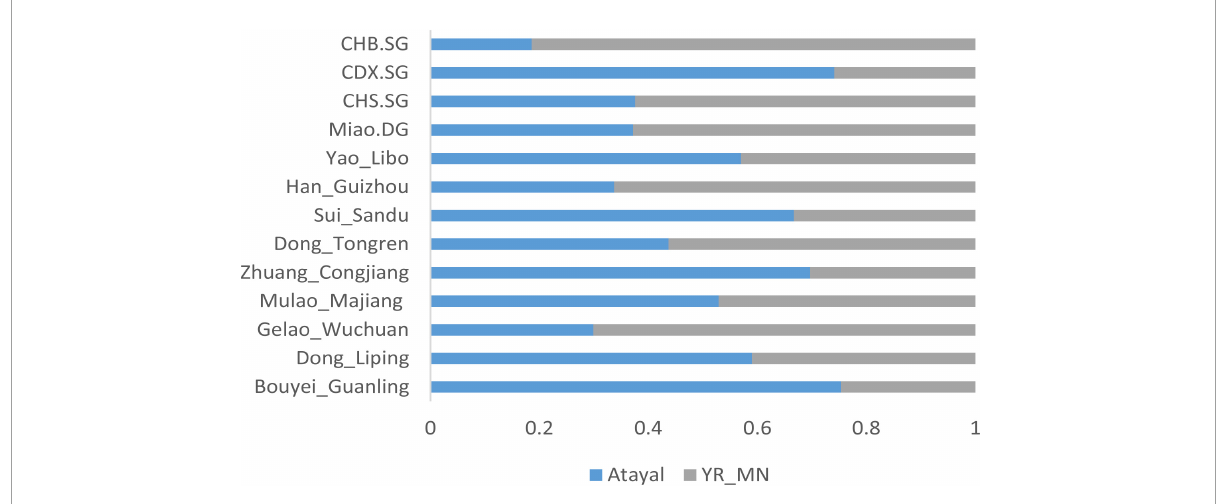
FIGURE6 Two-way admixture models showed the admixture landscape of the Guizhou Tai-Kadai-speaking population.